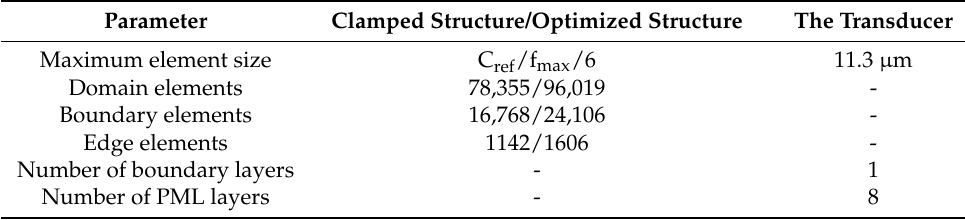
Table 1. Parameters of the mesh structures. Parameter Clamped Structure/Optimized Structure The Transducer Maximum element